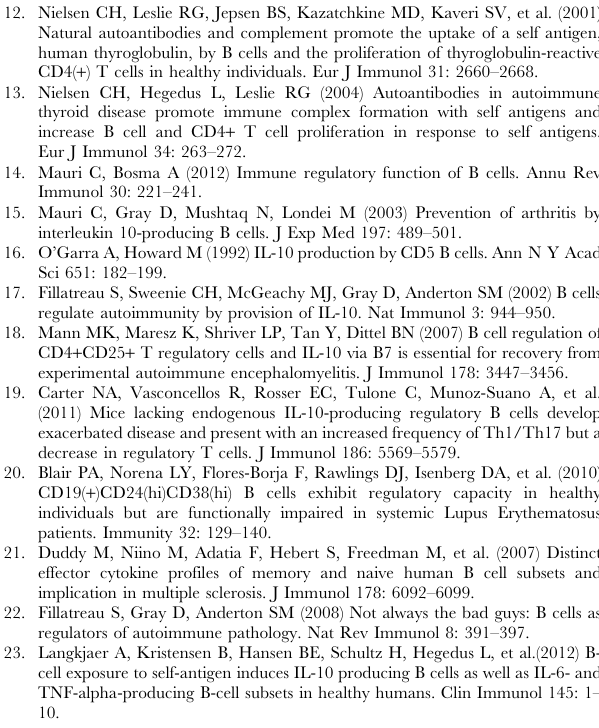
Figure S2 Phenotype of MBP85-99-presenting B cells. PBMCs from four healthy HLA-DR15 + donors were incubated with MBP (30 m g/ml) in RPMI medium containing 30% (v/v) normal serum. The presentation of MBP85-99 by CD19 + B cells antibody (A) or biotinylated MK16 + streptavidin-PE (C–D).